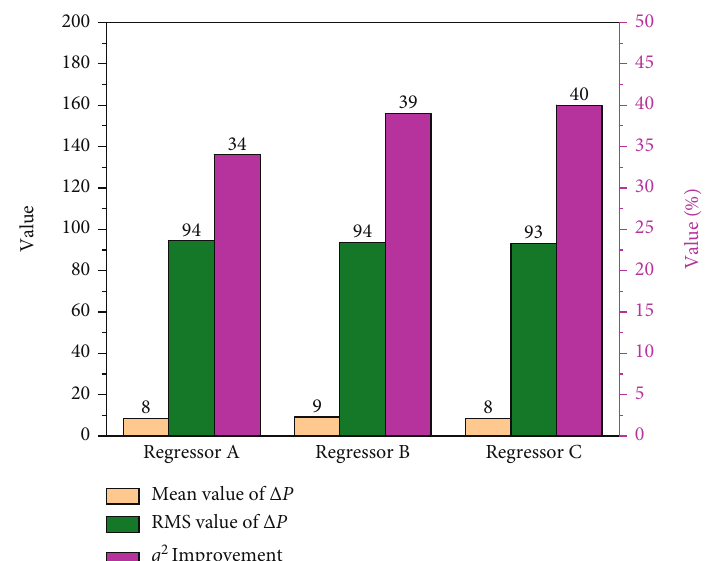
− P . “ Regressor A ” : linear regressor. “ Regressor B ” : best true